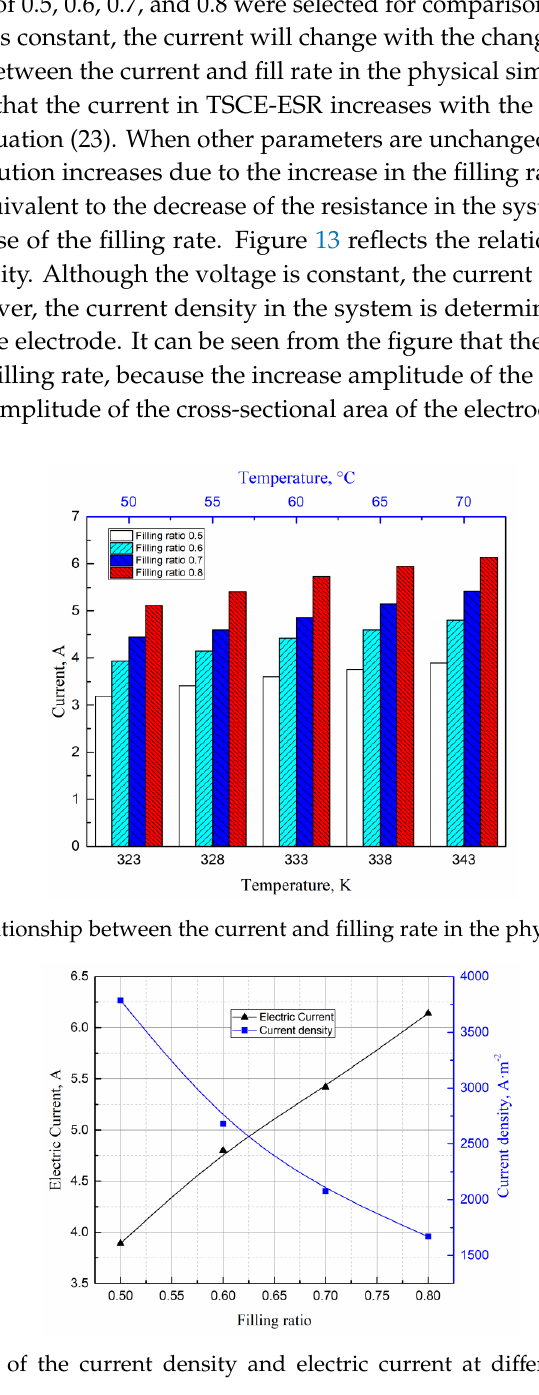
Figure 11. Variation of electric current with time, before and after droplet detachment.